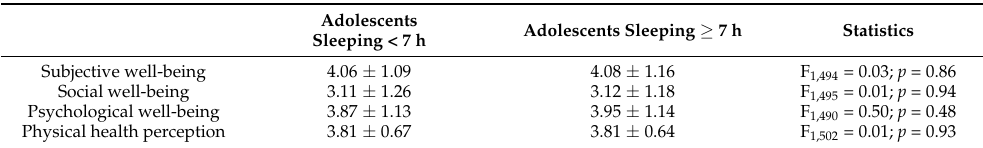
Table 2. Means and standard deviations of the subjective, social, and psychological well-being as well as physical health perception by sleep duration group. Statistics are also reported.